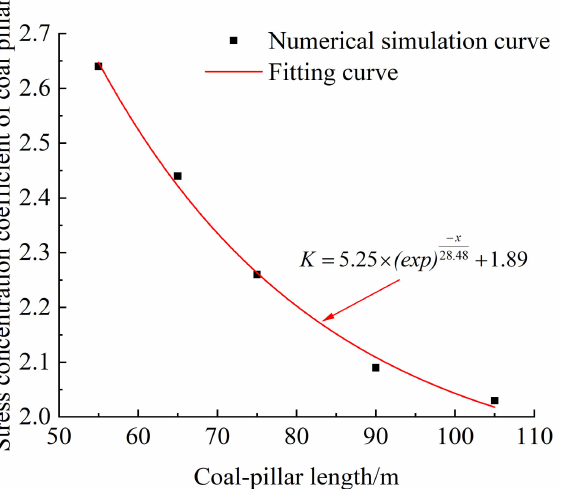
Figure 7. Relationship between coal-pillar lengths and stress concentration coefficients.